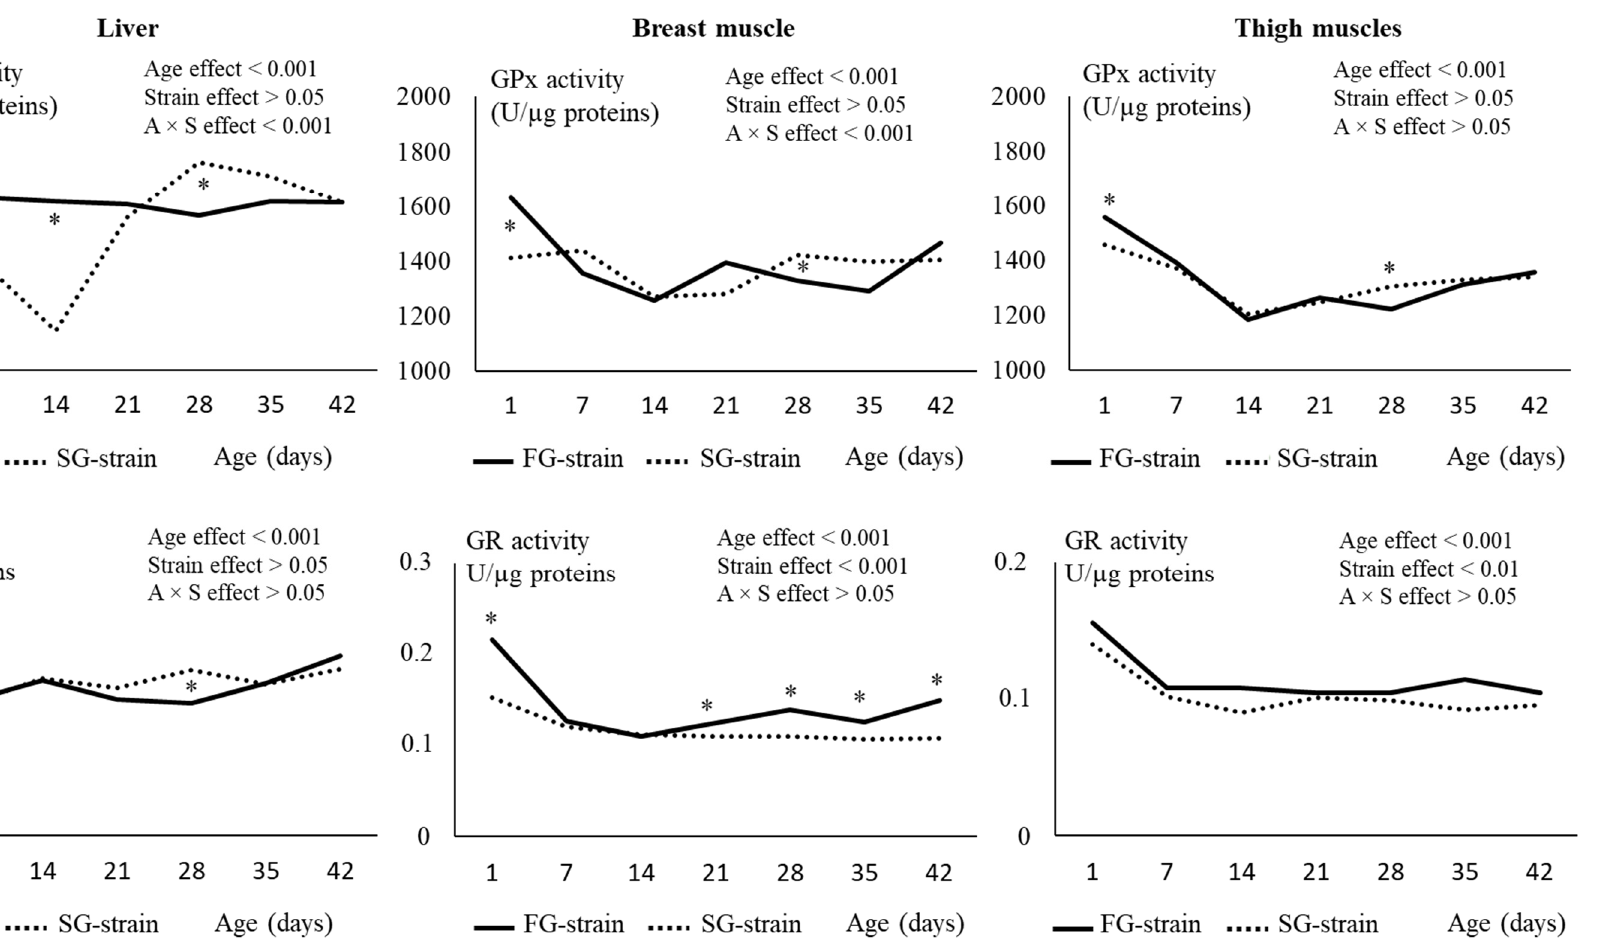
Figure 5. Effects of age (A) and strain (S) and their interaction on glutathione peroxidase (GPx) and glutathione reductase (GR) in the liver, breast, and thigh muscles. Data are presented as the means; n = 10 per strain and per age. *: Significant difference ( p < 0.05) between strains for a given age; FG = fast-growing, SG = slow-growing.